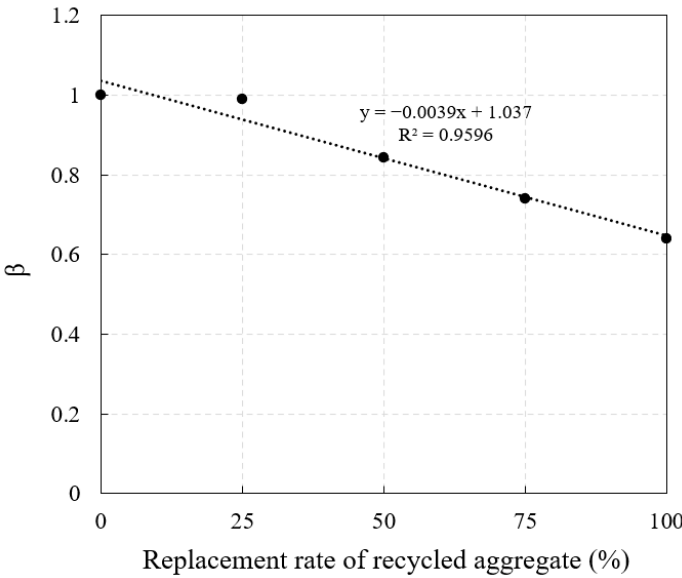
Figure 11. Relationship between influence coefficient of RA and replacement rate of RA.